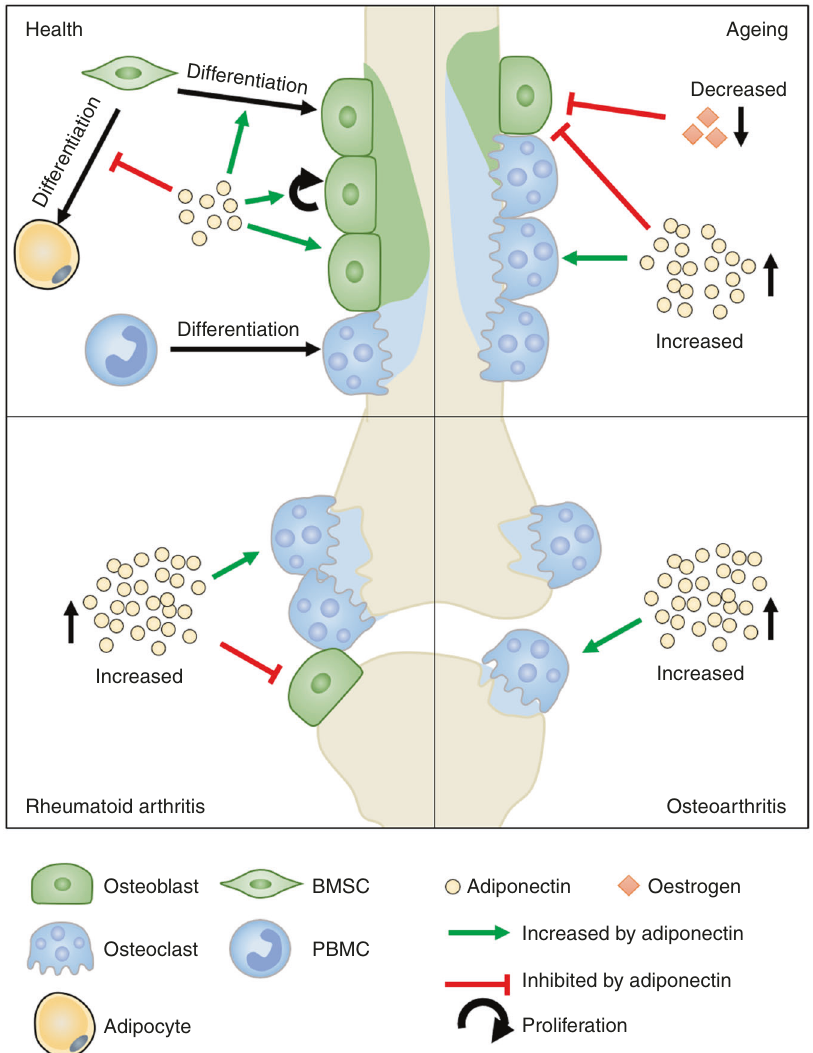
Fig. 3 Adiponectin signalling in bone. Under healthy conditions, adiponectin supports the proliferation, migration, mineralisation and survival of osteoblasts (green), whilst decreasing osteoclastogenesis and resorption (blue), ultimately leading to bone homeostasis. By contrast, these traits are broadly dysregulated in bones as we age and in patients with obesity or diseases such as rheumatoid arthritis and osteoarthritis: Increases in adiponectin, or changes in environmental cues (including levels of oestrogen) that impact the downstream signalling pathways triggered by adiponectin (e.g. MAPK vs AMPK), pathologically tip the balance in favour of bone resorption and damage (blue) in these